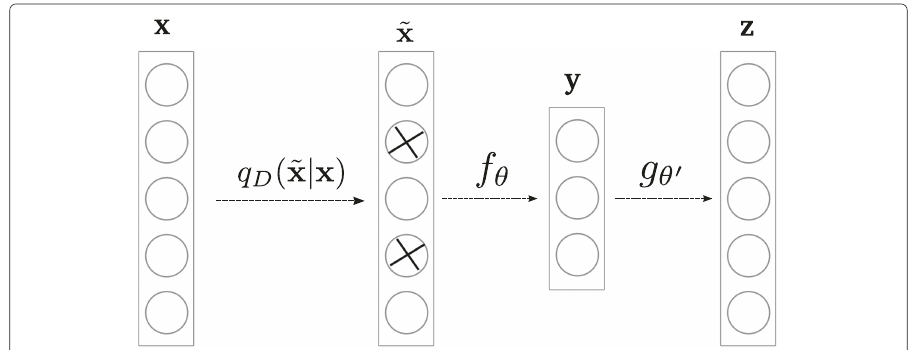
Fig. 2 Denoising Autoencoder. A corrupted instance ˜ x of a graph x is fitted into the Autoencoder’s input. The Autoencoder is trained to recover a cleaned version of the input by compressing it through a non-linear mapping f θ and mapping it back (through g θ (cid:4) ) to a reconstructed version of the original input graph x